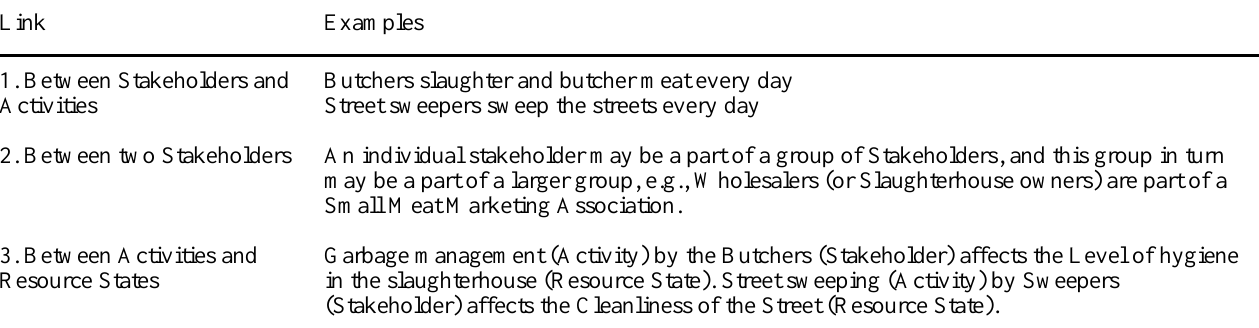
Table 2. Links between eco-social system elements contributing to ecosystem health.